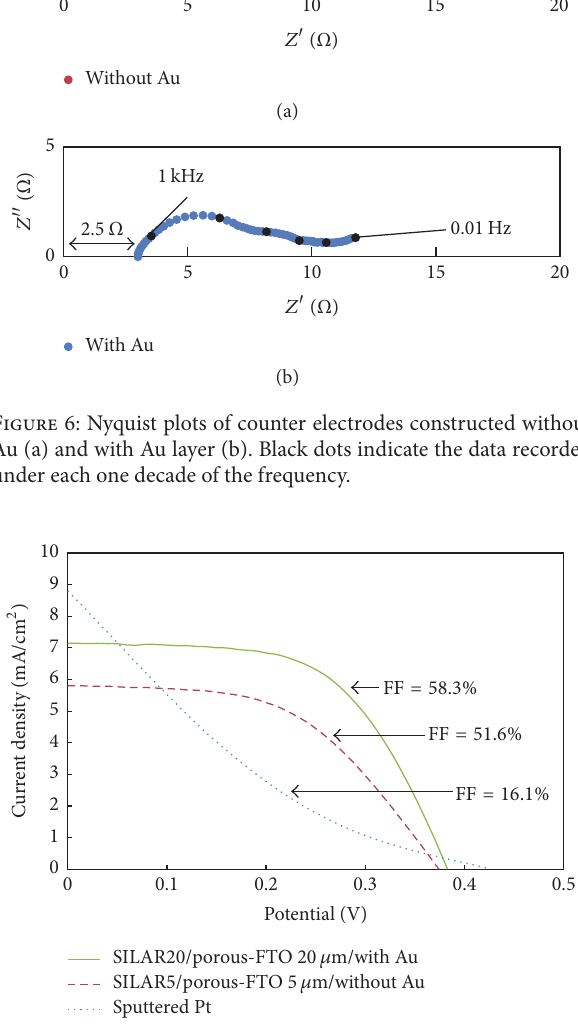
Figure 7: I-V curves of QDSSCs constructed with various counter electrodes under solar simulator. Blue dotted line: Pt counter elec- trode, red dashed line: porous-FTO/CuS (porous-FTO thickness: 5 𝜇 m, SILAR cycles: 5 times), and solid green line: Au/porous- FTO/CuS (porous-FTO thickness: 20 𝜇 m, SILAR cycles: 20 times),